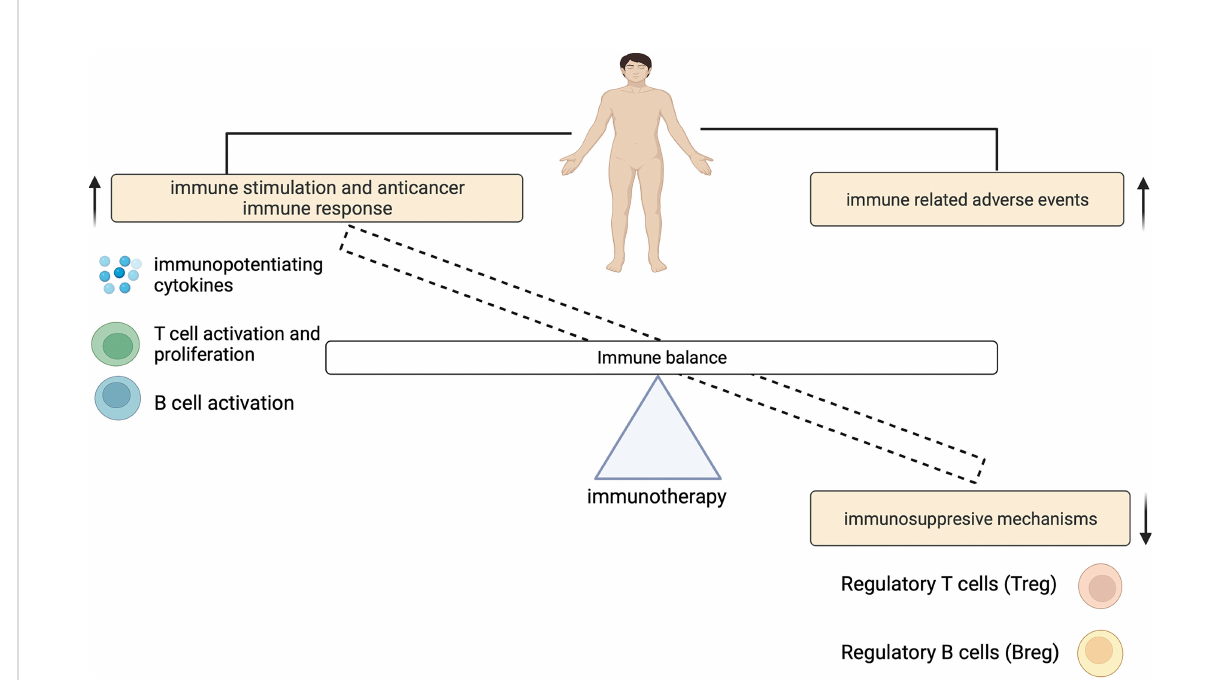
FIGURE 2 An imbalance of the immune system can cause immune related adverse